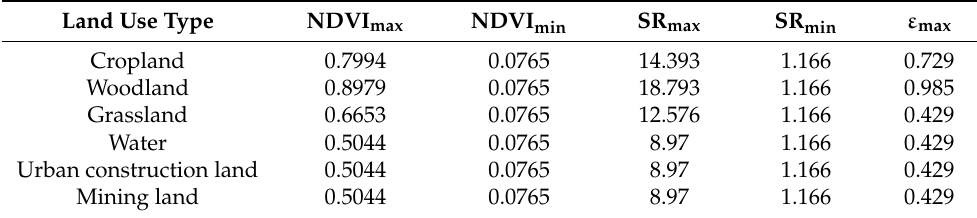
Table 2. Parameters of the CASA model for different land use types. Land Use Type NDVI max NDVI